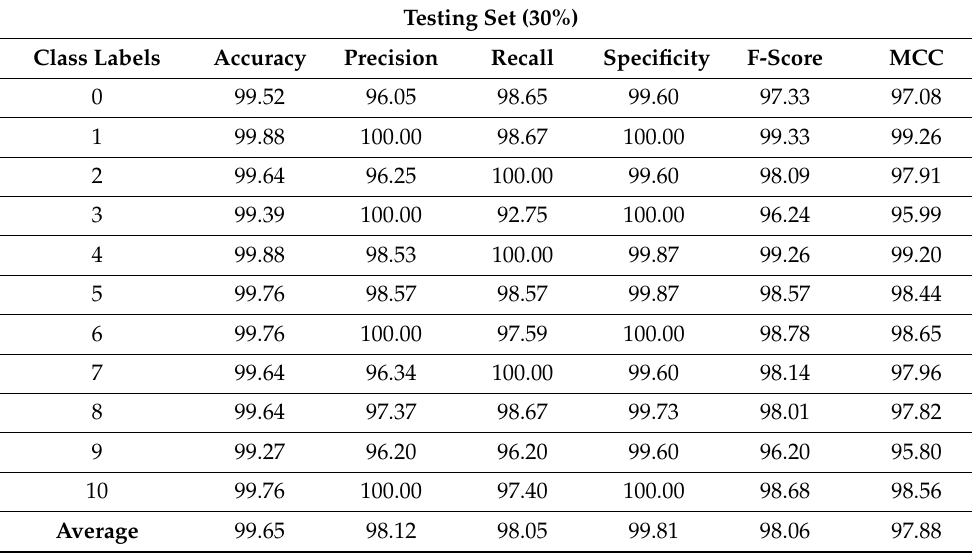
Table 4. Result analysis of SFODLD-SAC technique with distinct measures on 30% of TSS. Testing Set (30%)